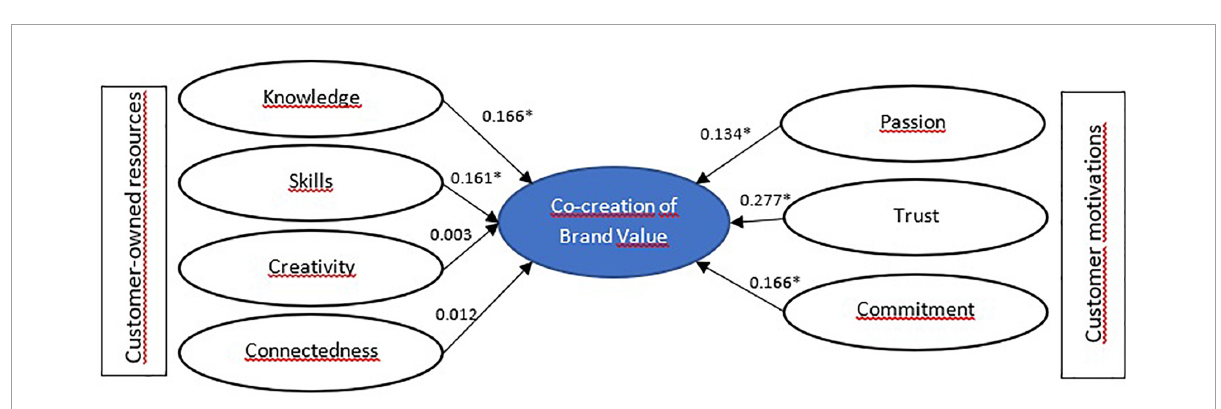
FIGURE3 Model estimation for skeptical customers—Segment 2. ∗ p < 0.05.